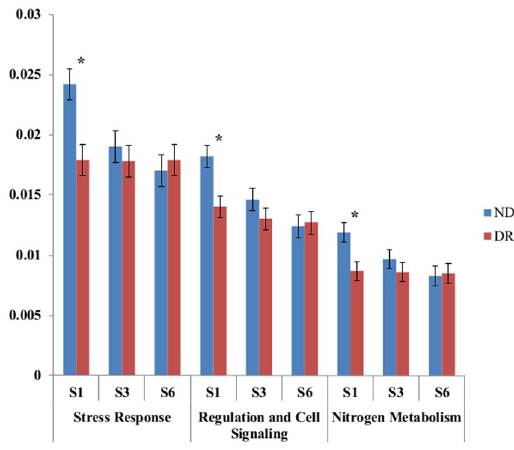
Figure 1. Abundance of “stress response”, “regulation and cell signaling”, and “nitrogen metabolism”. Sequences in fecal samples collected from control calves (NR) and calves feed milk containing low concentrations of drug residues (DR) for samples collected as 1 (S1), 3 (S3) and 6 (S6) weeks after beginning of trial. Values are expressed as a percentage of the total sample sequences assigned function. The symbol * indicates significant differences ( P -value ≤ 0.05). Error bars represent 95% confidence interval of the least square mean.